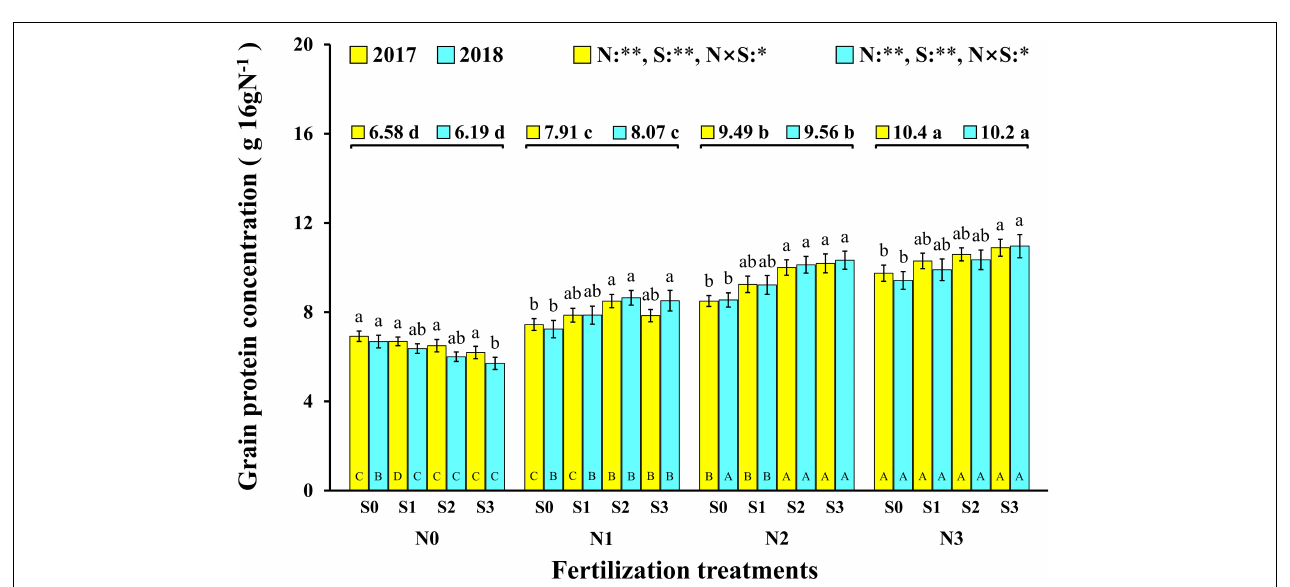
FIGURE 3 | Effect of N and S on grain protein concentration of maize. The data are the means of four replicates, and the error bars represent the standard deviation. The lowercase letters above the bars indicate the significant differences between the different S rates at the same N level in the same year, and the different uppercase letters in the bars indicate the significant differences between the different N rates at the same S level in the same year. The number on the horizontal line above each group of bars indicates the average value of protein concentration of maize at different N levels in the same year, and the lowercase letters after the numbers indicate the significant difference in protein concentration at different N levels. The variance analysis used two-way ANOVA ( ∗∗ P < 0.01, ∗ P < 0.05).